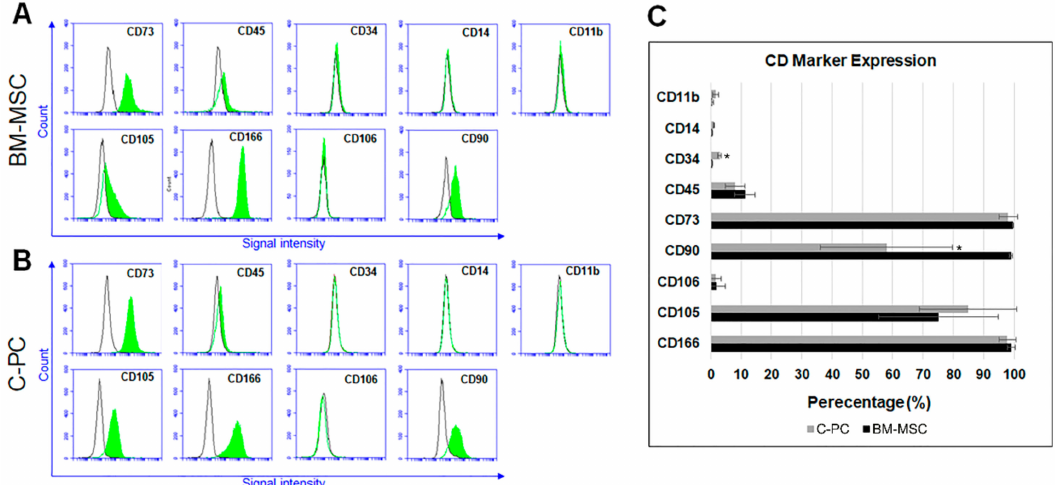
Figure 1. Immunotypic comparison of cartilage-derived progenitor cells (C-PCs) and bone marrow-derived mesenchymal stem cells (BM-MSCs). ( A ) The cell surface marker profile of BM-MSCs and ( B ) C-PCs as determined using flow cytometry. Color filled peaks indicate the percentage of cells that stained positively for each antibody. Empty, noncolored peaks represent the results of cells that were stained with isotype control antibodies. ( C ) Percentage of cells that stained positively for each tested antibody is shown in a representative bar graph. *, p ≤ 0.05, compared to respective BM-MSC groups and ( N = 3 replicate